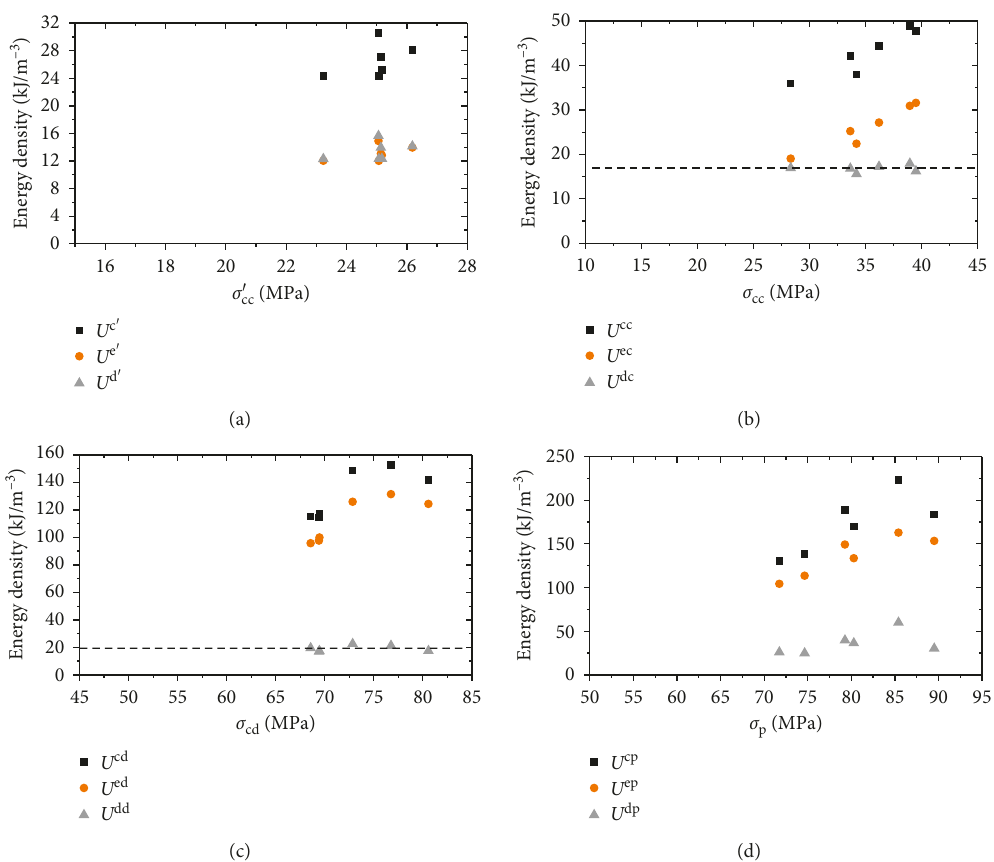
Figure 11: Relationship between the energy densities and the characteristic stresses during the different phases: (a) σ